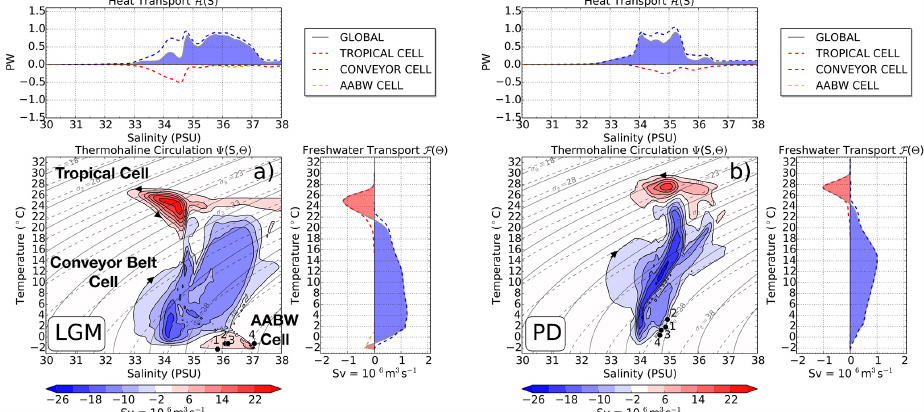
Figure 6. Thermohaline streamfunction computed for (a) the LGM simulation and (b) the PD simulation. The contour interval for the circulation is 4Sv. The blue cells correspond to clockwise circulations whereas the red cells are for counter-clockwise motions. The upper diagram correspond to the oceanic heat transport within each isohaline is plotted. The left diagram shows the freshwater transport within each isotherm. The black dots represent the deep ocean temperature and salinity from Adkins et al. (2002): 1: Bermuda Rise, 2: Feni Drift, 3: Chatham Rise, 4: Shona Rise.